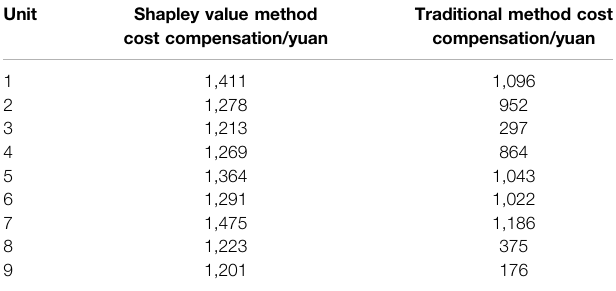
TABLE 3 | Compensation for unit peak shaving costs under different methods.